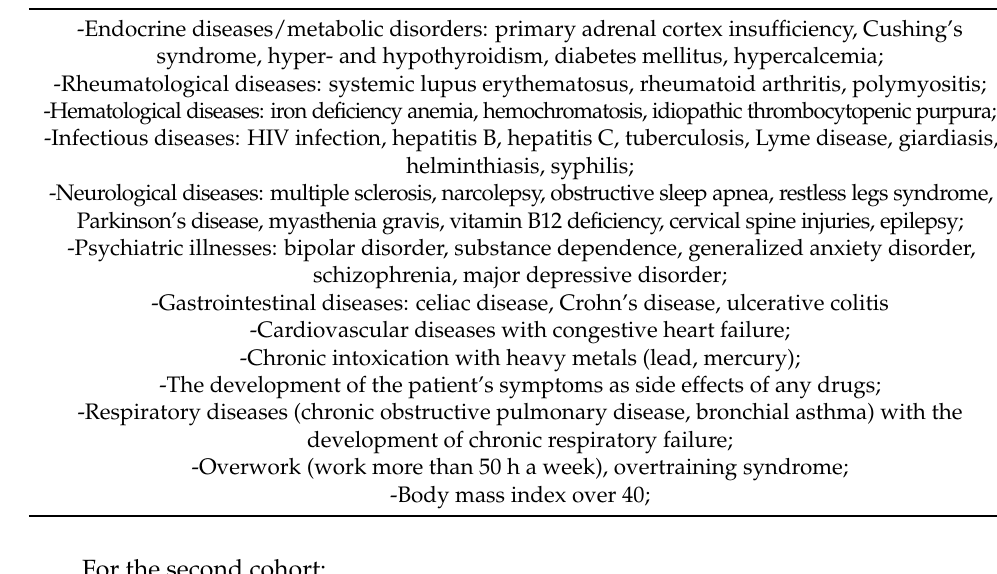
Table 1. Exclusion criteria for the first cohort (exclusion criteria for diagnosis of ME/CFS) [16]. -Endocrine diseases/metabolic disorders: primary adrenal cortex insufficiency, Cushing’s syndrome, hyper- and hypothyroidism, diabetes mellitus, hypercalcemia; -Rheumatological diseases: systemic lupus erythematosus, rheumatoid arthritis, polymyositis; -Hematological diseases: iron deficiency anemia, hemochromatosis, idiopathic thrombocytopenic purpura; -Infectious diseases: HIV infection, hepatitis B, hepatitis C, tuberculosis, Lyme disease, giardiasis, helminthiasis, syphilis; -Neurological diseases: multiple sclerosis, narcolepsy, obstructive sleep apnea, restless legs syndrome, Parkinson’s disease, myasthenia gravis, vitamin B12 deficiency, cervical spine injuries, epilepsy; -Psychiatric illnesses: bipolar disorder, substance dependence, generalized anxiety disorder, schizophrenia, major depressive disorder; -Gastrointestinal diseases: celiac disease, Crohn’s disease, ulcerative colitis -Cardiovascular diseases with congestive heart failure; -Chronic intoxication with heavy metals (lead, mercury); -The development of the patient’s symptoms as side effects of any drugs; -Respiratory diseases (chronic obstructive pulmonary disease, bronchial asthma) with the development of chronic respiratory failure; -Overwork (work more than 50 h a week), overtraining syndrome; -Body mass index over